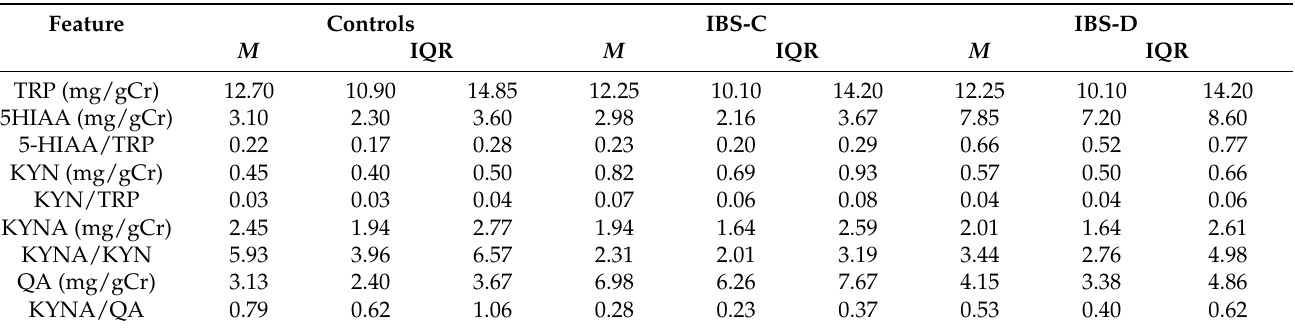
Table 2. Urinary excretion of tryptophan and its metabolites in healthy subjects (controls, C) and in patients with constipation-predominant (IBS-C) and with diarrhoea-predominant (IBS-D) irritable bowel syndrome; median ( M ) ± interquartile range (IQR).